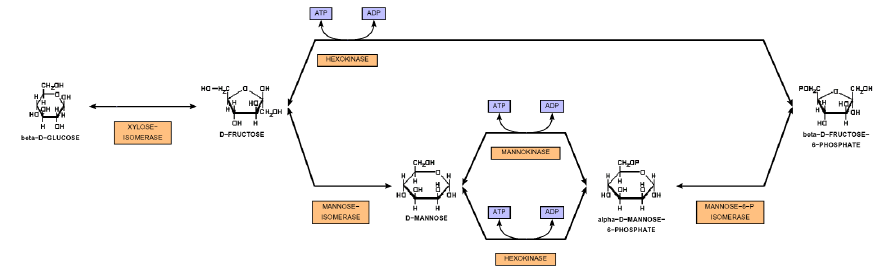
Fig. 1. A metabolic pathway.